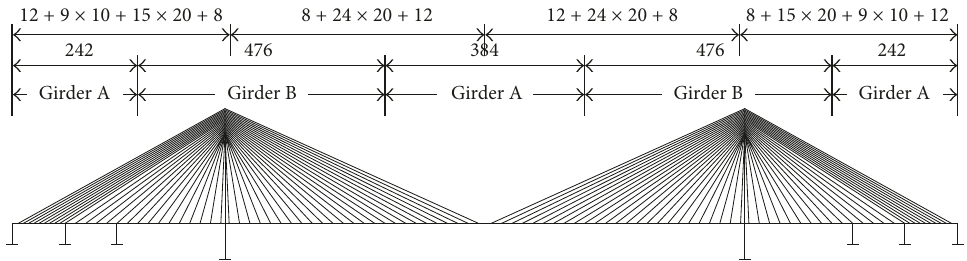
Figure 1: General layout of cable-stayed bridges with a 1000m span (unit: m).